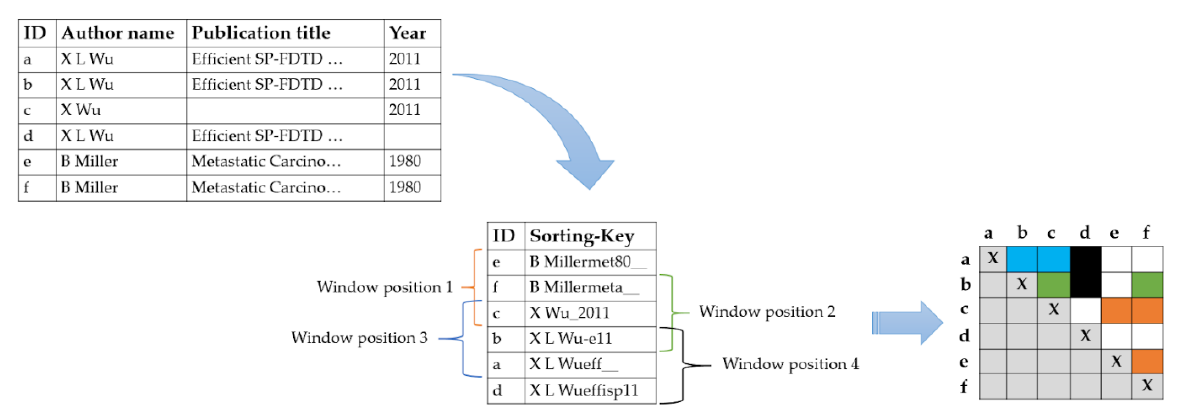
Figure 4. Sorted neighborhood procedure.